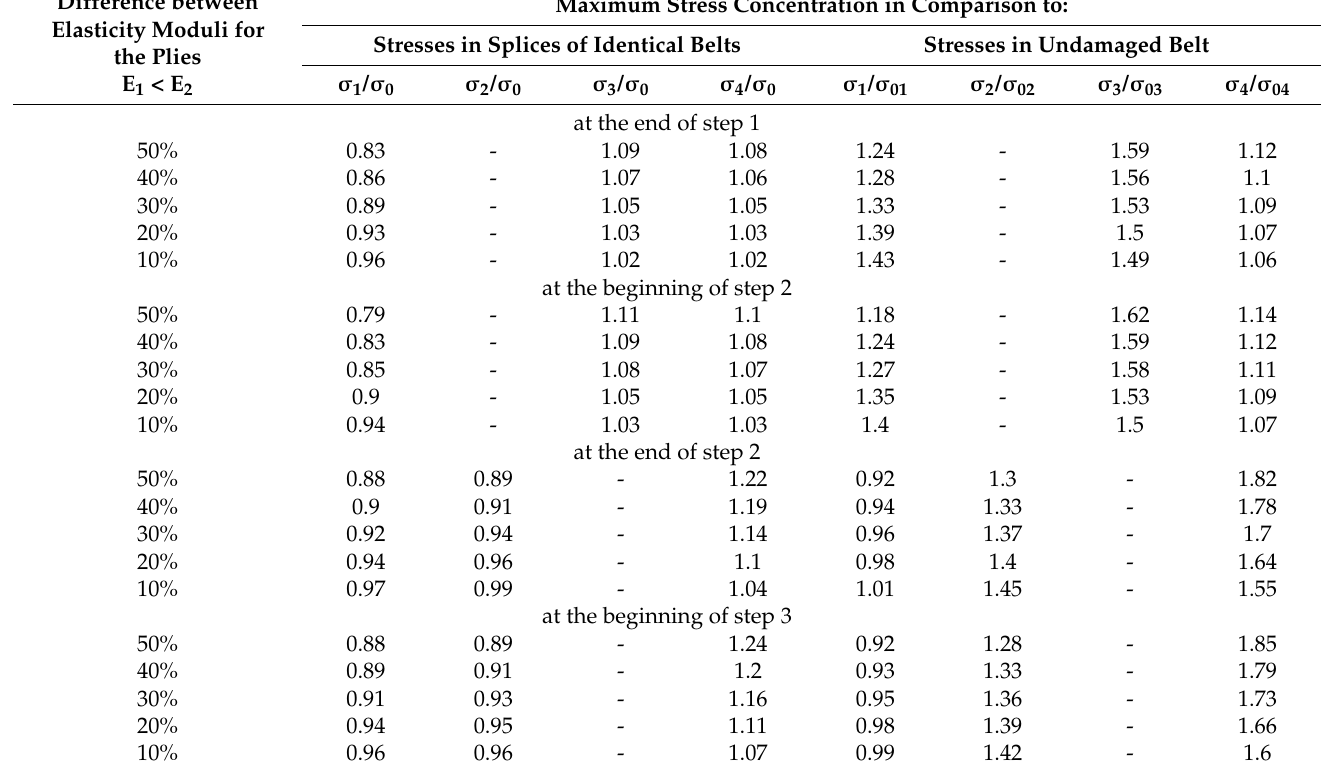
G = 750 kN/m 2 , d = 0.001 m. Table 1. Calculated values of stress